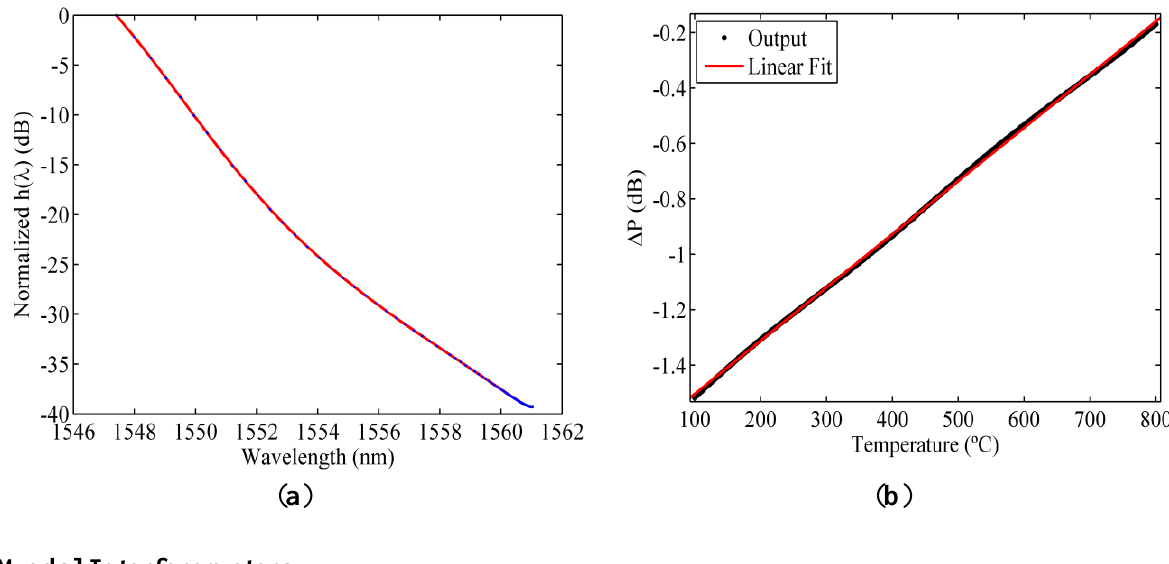
Figure 4. ( a ) Optical spectrum of the ideal filter; ( b ) Simulated output of the proposed interrogation setup using the ideal